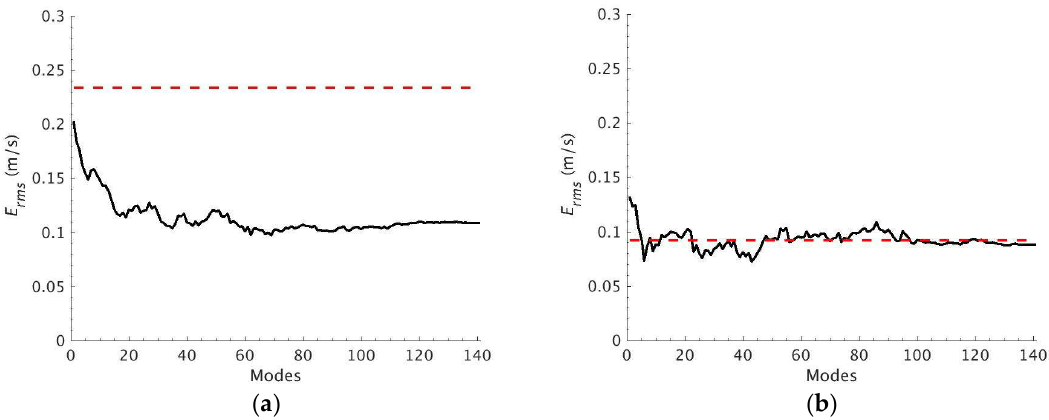
Figure 6. Averaged root mean squared error ( E rms ) between POD reconstructed wave orbital velocity time series and ground truth wave buoy measured orbital velocity time series for each (1 to n ) mode reconstruction (black line), and between FFT-based dispersion curve filtered time series and wave buoy ground truth (red dashed line) for dataset 1 (a) and dataset 2 (b). Table 2. Correlation coefficient ( c ) and E rms for both wave retrieval methods: proper orthogonal decomposition (POD) and dispersion filtering (FFT) for each dataset. For POD, the peak c and minimum E rms are provided with the mode selection (modes 1- n ) shown parenthetically.